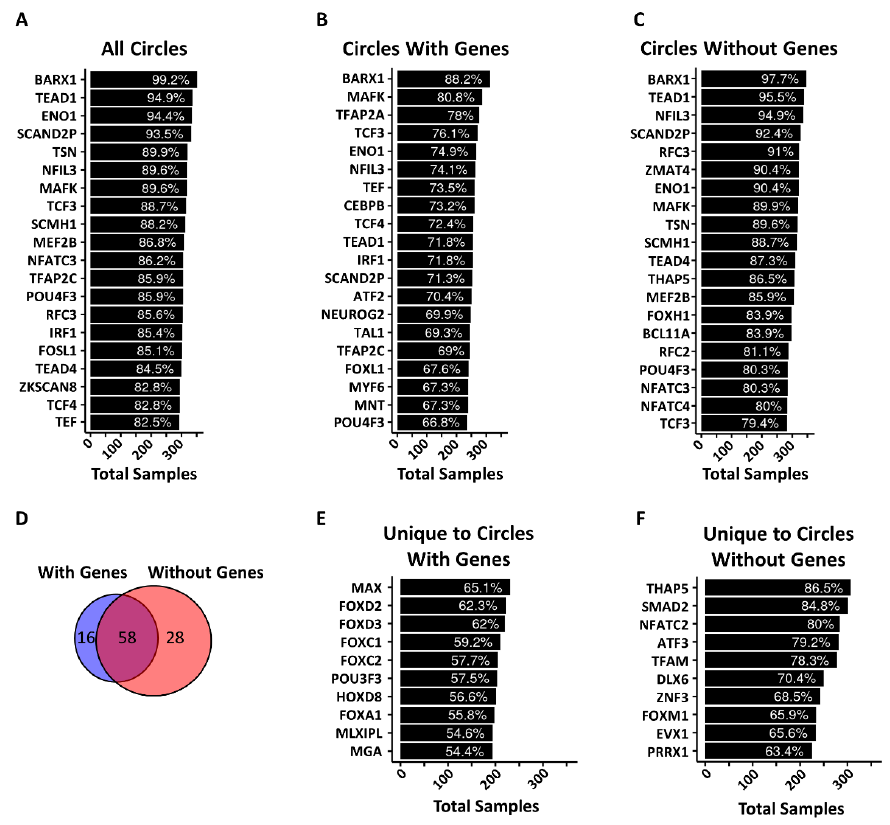
Figure 6. DNA binding motifs are enriched at circle breakpoints. ( A ) Most commonly enriched DNA binding motifs found within ± 250 bp of a circle breakpoint for individual tumors. The white lettering shows the percent of tumors with enrichment of the motif while the length of the bar is the absolute number of tumors. ( B ) Most commonly enriched DNA binding motifs found within ± 250 bp of the breakpoint of circles with genes for individual tumors. The white lettering shows the percent of tumors with enrichment of the motif while the length of the bar is the absolute number of tumors. ( C ) Most commonly enriched DNA binding motifs found within ± 250 bp of the breakpoint of circles without a gene for individual tumors. The white lettering shows the percent of tumors with enrichment of the motif while the length of the bar is the absolute number of tumors. ( D ) Venn diagram depicting the overlap of the total number of enriched motifs found in at least 50% of tumors for circles with genes and circles without genes. ( E ) Ten most commonly enriched DNA binding motifs in circles with genes that are not enriched in circles without genes. ( F ) Ten most commonly enriched DNA binding motifs in circles without genes that are not enriched in circles with genes. All values of significance were calculated in the PWMEnrich R package and are based on a simulated modified Fisher’s exact test. Values less than 0.001 were considered significant for this analysis. The complete list of factors with motif enrichments can be found in Tables S4 and